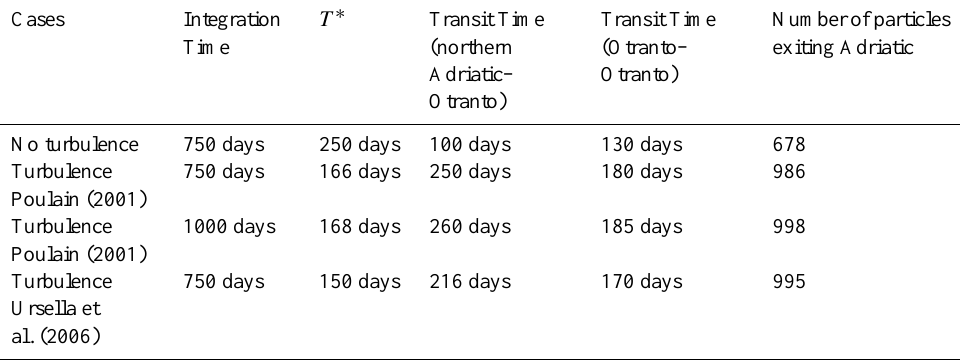
Table 1. Summary of transit and residence time statistics using numerical